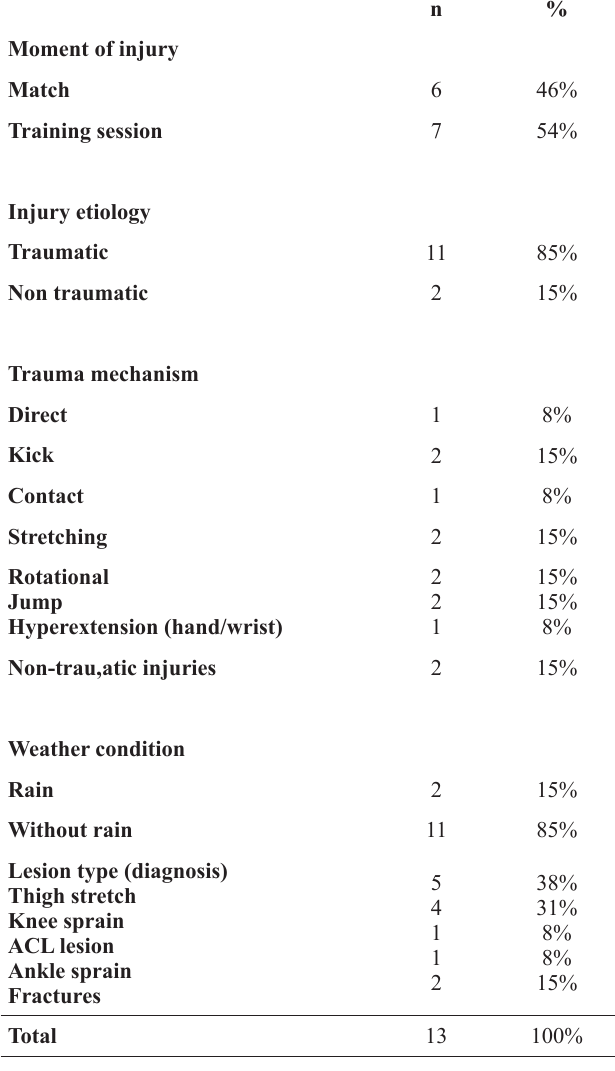
Table 2. Characteristics of lesions diagnosed in male soccer athletes in the city of Aracaju - season 2014.